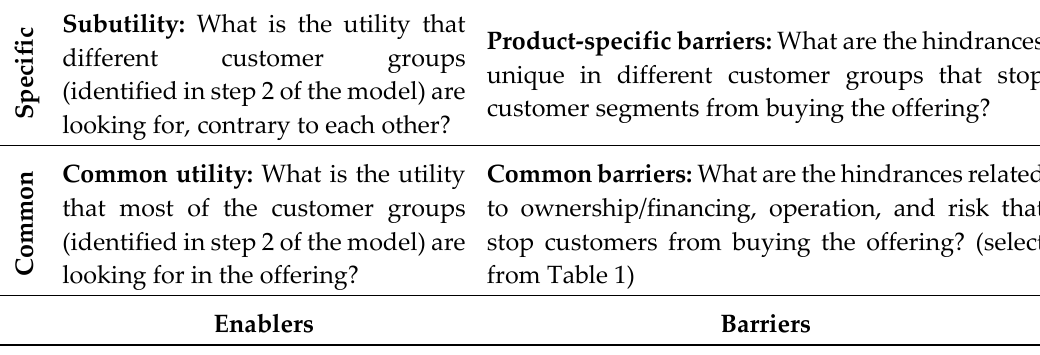
Figure 4. Framework for the identification of enablers and barriers.